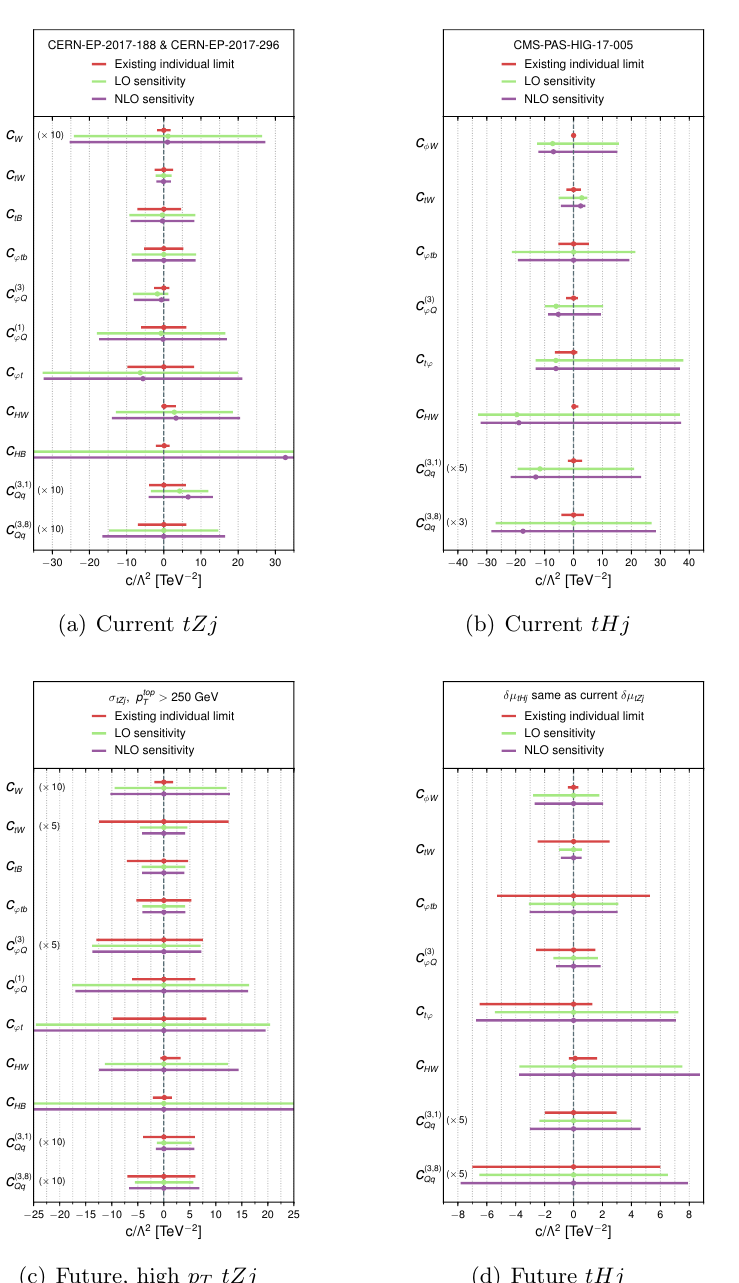
Figure 6 . Con(cid:12)dence intervals on the Wilson coe(cid:14)cients of interest derived from a) the signal strength measurements of the tZj process by ATLAS [25] and CMS [27] and b) from the combined signal strength measurement of t (cid:22) tH tHj and tHW by CMS [80] assuming only modi(cid:12)cations to tHj apart from the modi(cid:12)cations to t (cid:22) tH induced by . Future sensitivity is shown in c) O t’ for tZj , assuming the same accuracy as for the current inclusive measurement is achieved in the p top > 250 GeV region and in d) for tHj , assuming the accuracy of the current tZj inclusive T measurement is achieved. See text for further details. In all cases the existing limits quoted in table 3 as also included for reference.